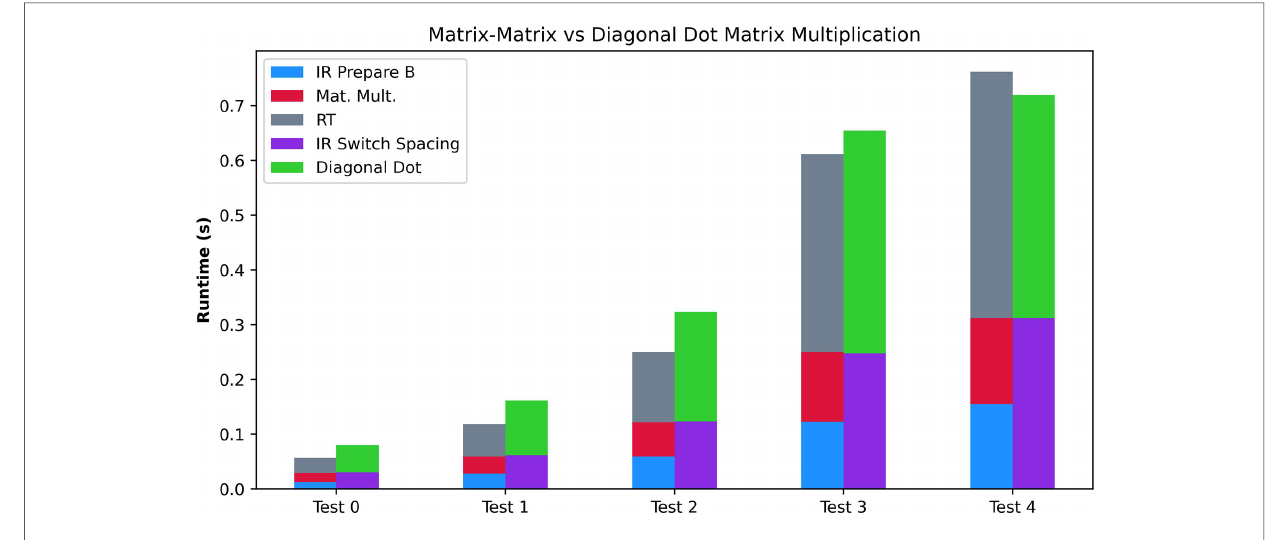
FIGURE 8 Performance comparison of the Matrix-Matrix Multiplication Algorithm and the Diagonal Matrix Multiplication